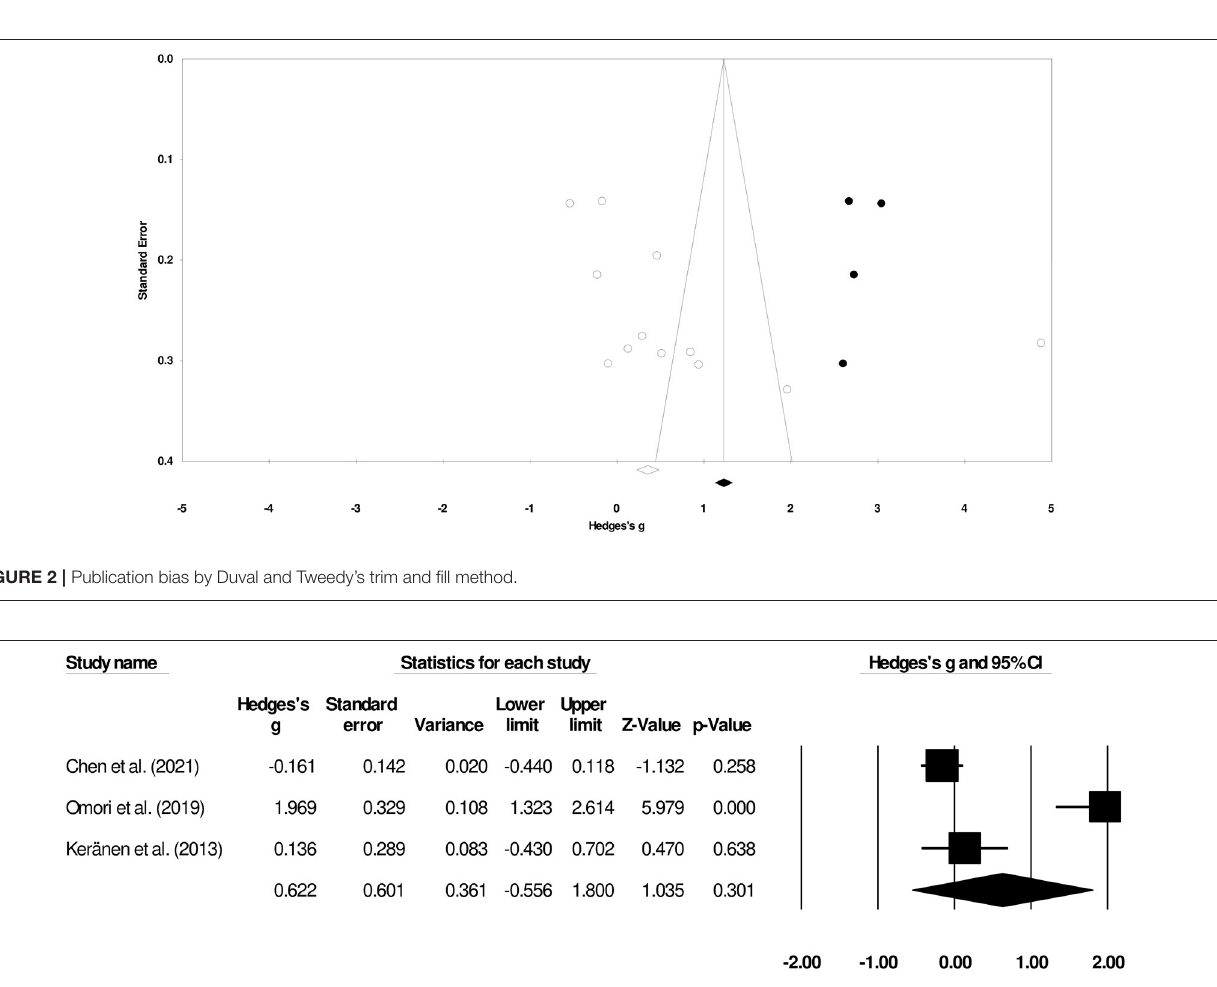
FIGURE 3 | Forest plot for studies comparing the overall time to oral intake for patients undergoing gastrojejunostomy or palliative